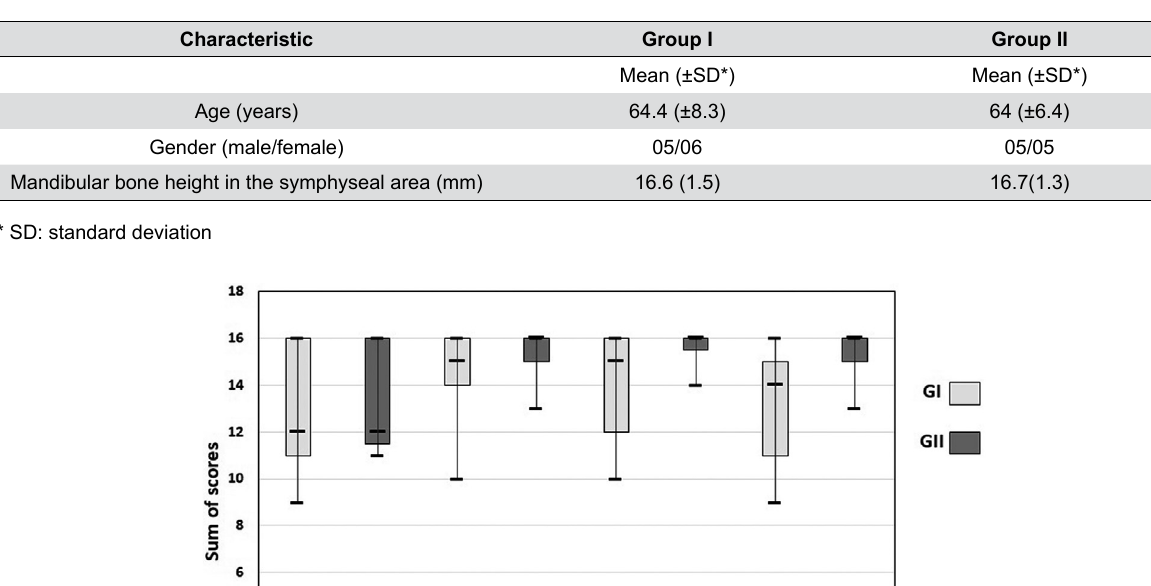
Table 1- Baseline characteristics of patients in both groups